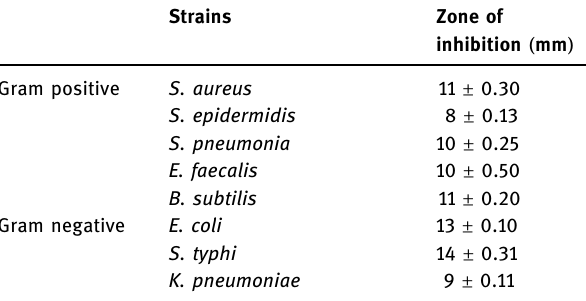
Table 1: Antibacterial activity of the biosynthesized AgNPs prepared with aqueous R. o ffi cinalis leaf extract against eight bacterial species tested by disc di ff usion assay